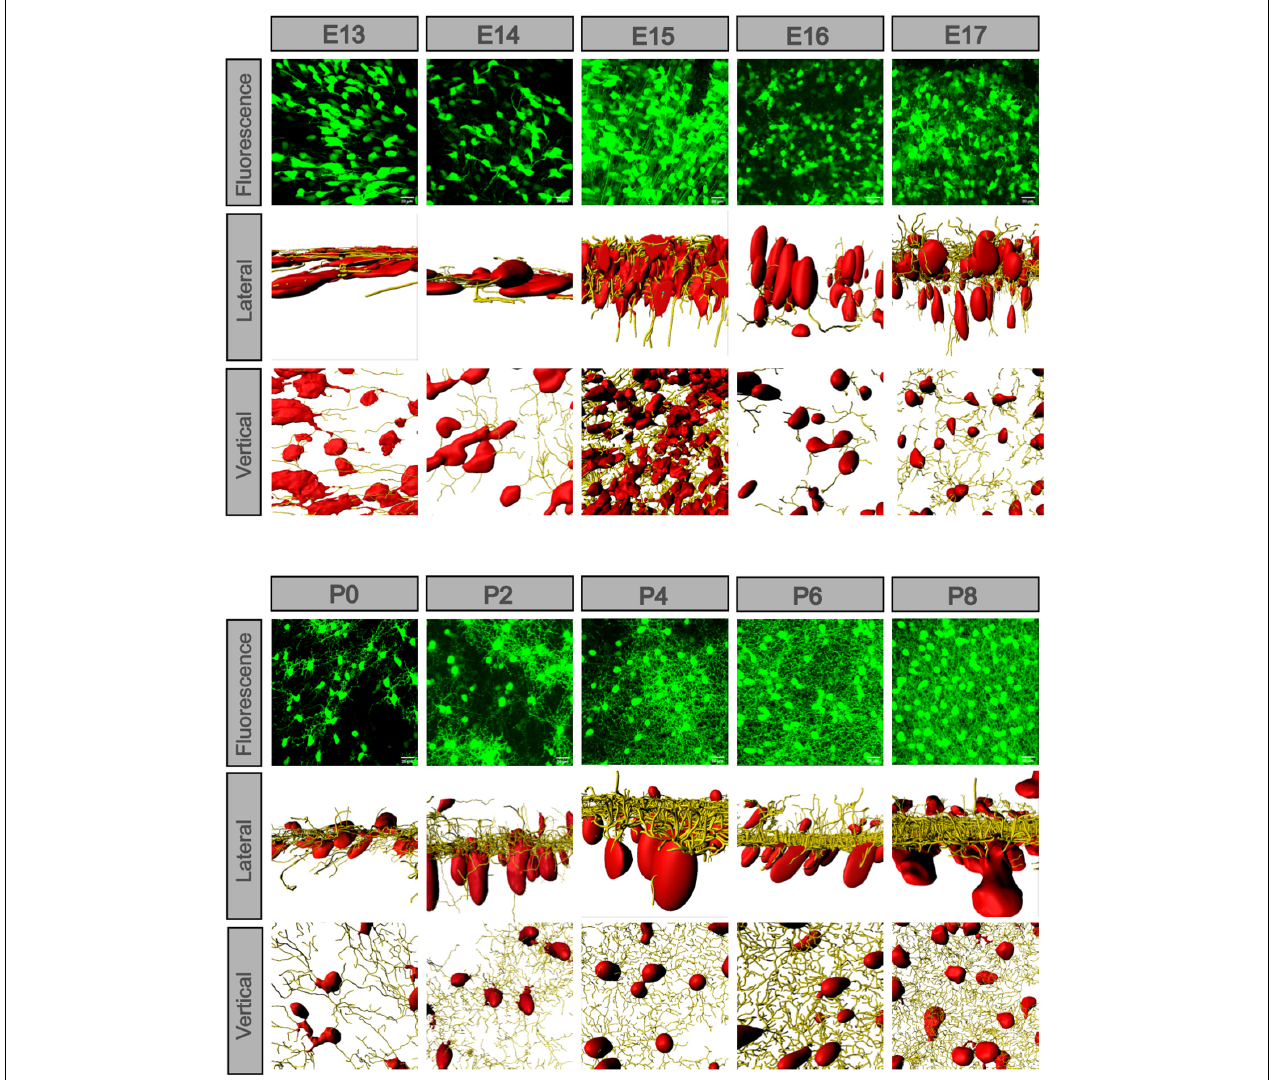
FIGURE 5 | POMC-positive cell axons and dendrites exchanged along with the soma morphology. The fluorescence image was z-stacked. The vertical and lateral view images were masked by the Imaris surface and filament function. From E13 to P8, the lateral view showed that cell soma changed from flat to ellipsoidal and gradually separated into two layers, and so did the dendrites. At E13 and E14, there were only axons in the same direction; at E15, the axons were strongest. At E16, the axons disappeared, and dendrites developed. From P0 to P8, the dendrites formed two sublaminas and were regularly weaved. From a vertical view, the cell density changed, and dendrites gradually filled the whole field. Bar = 20 µ